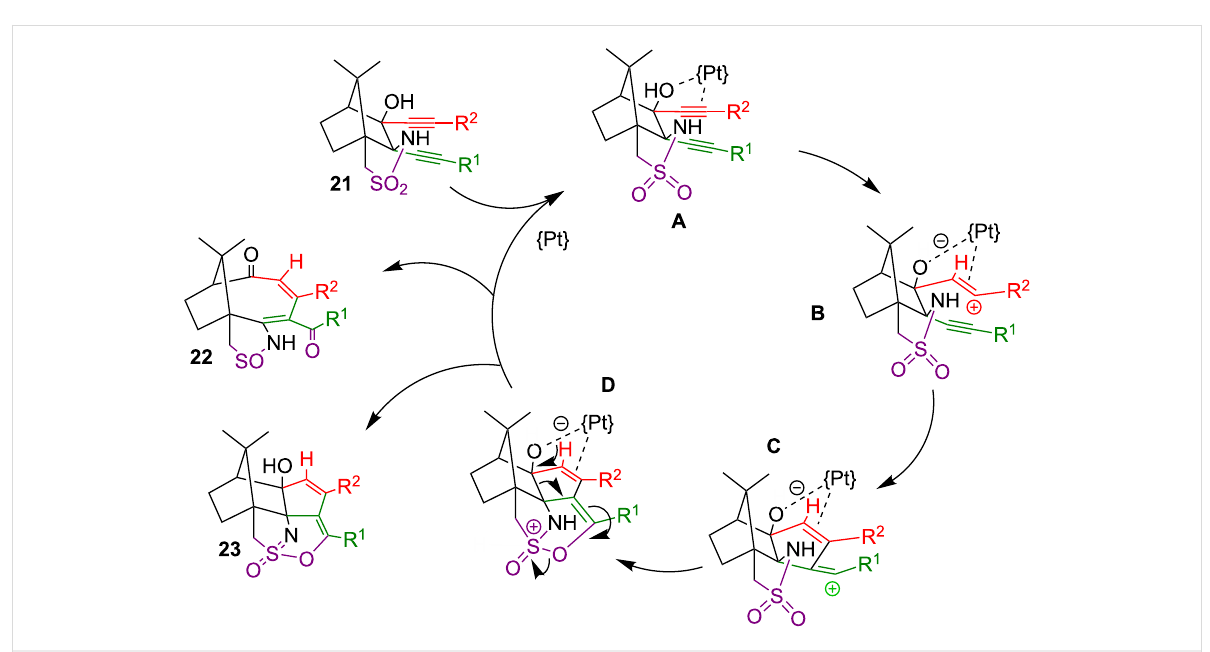
Scheme 8: Proposed mechanism of the platinum-catalysed cycloisomerisation.